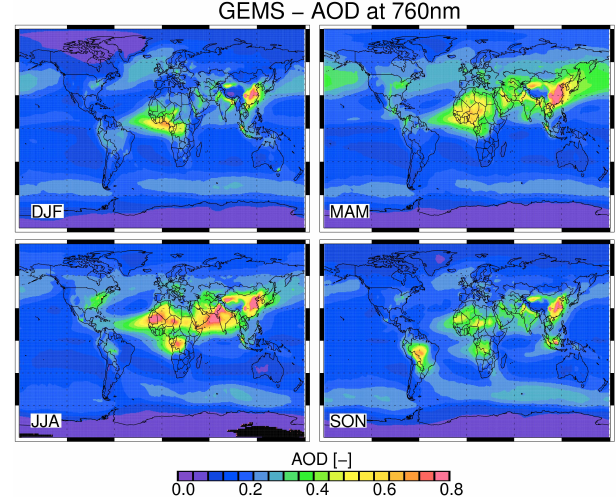
Fig. 4. Seasonal averages of aerosol optical depth (AOD) at 760nm based on the GEMS aerosol data product of the years